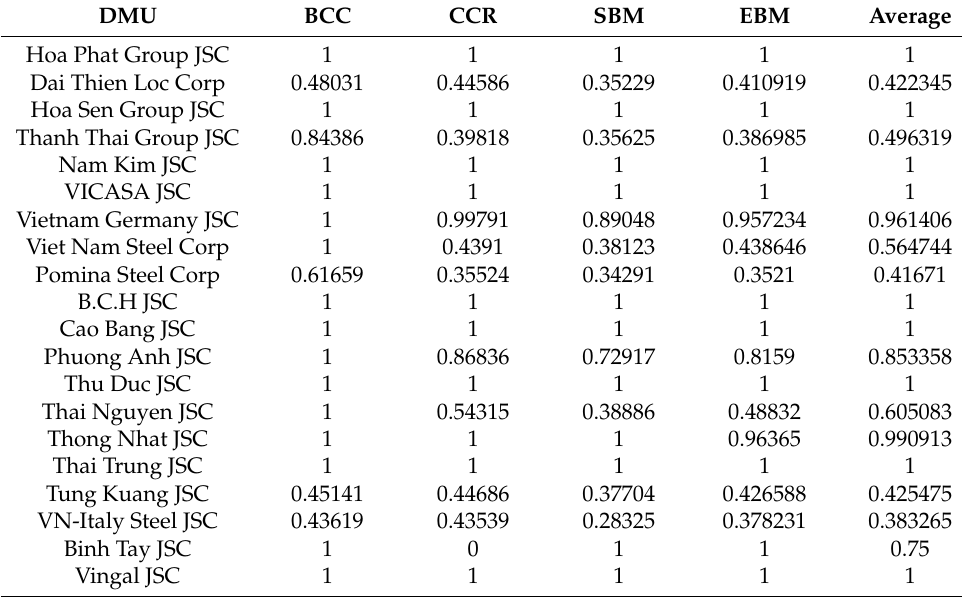
Table 7. Efficiency scores of suppliers in the DEA models.